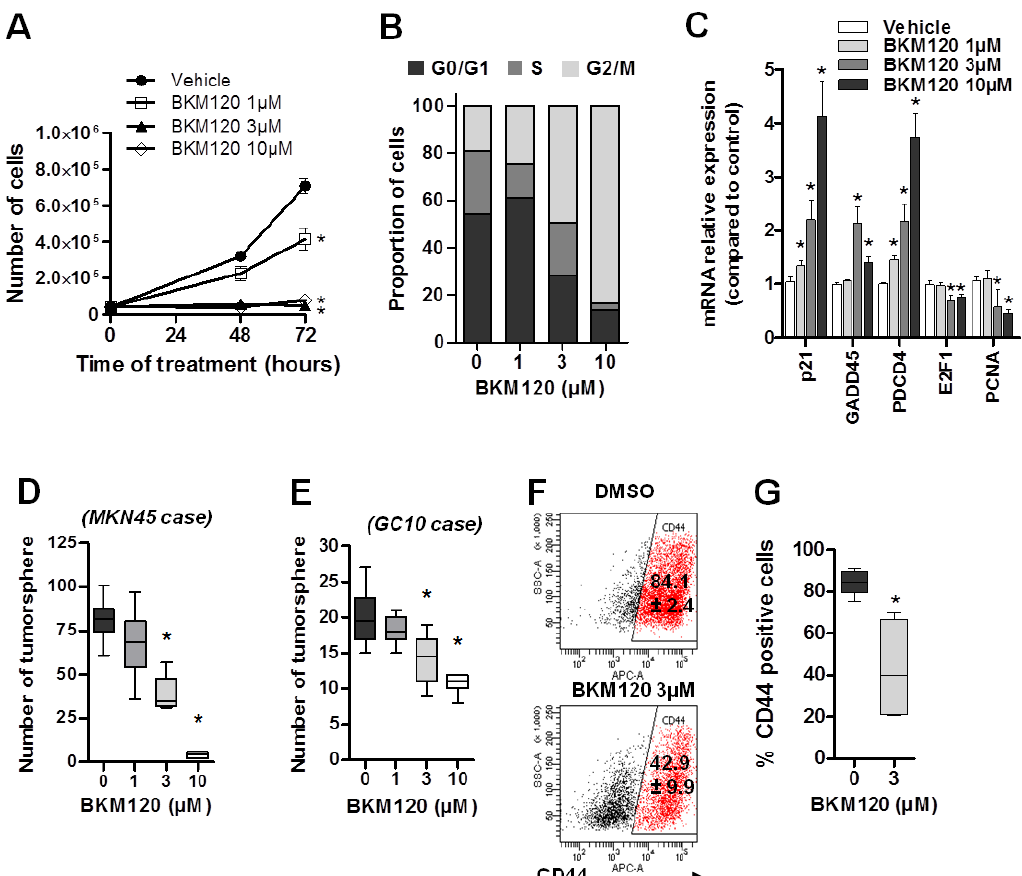
Figure 4. Buparlisib (BKM120) inhibits GC cell proliferation and decreases CSC population and tumorigenic properties. Adherent cells were treated with increasing concentrations of BKM120 or with DMSO as control (vehicle) for 48 h and viability assay ( A ), flow cytometry cell cycle assay ( B ), and relative mRNA expression levels of genes controlling cell-cycle progression ( C ) were performed. n = three independent experiments. * p < 0.05 compared to control, one-way ANOVA test. MKN45 ( D ) and GC10 ( E ) cells were cultured under non-adherent culture conditions with 1 to 10 µ mol / L BKM120 or DMSO for seven days, and the number of tumorspheres formed by 200 or 1000 seeded cells per well, respectively, were quantified ( D , E ). Data represent the min to max. n = three independent experiments with nine replicates per condition. * p < 0.05 in one-way ANOVA test. Cells dissociated from MKN45-treated tumorspheres were stained with anti-CD44-APC antibodies and analyzed by flow cytometry ( F , G ). ( F ) Representative dot plot images of flow cytometry analyses and ( G ) quantification of the percentage of CD44-positive cells. Values indicate the mean ± SEM of CD44-positive cells in three independent experiments each performed in duplicates. * p < 0.05 vs. control (DMSO alone), Mann–Whitney test.